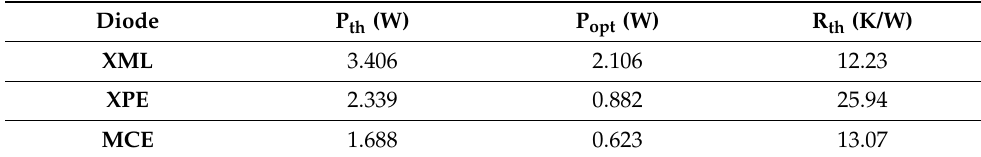
Figure 13. Dependences of self thermal resistance (solid lines) and transfer thermal resistance (dotted lines) between di- odes contained in the MCE device on forward current for the device mounted with the use of a thermal pad ( a ) and without a thermal pad ( b ) obtained using the custom set-up.